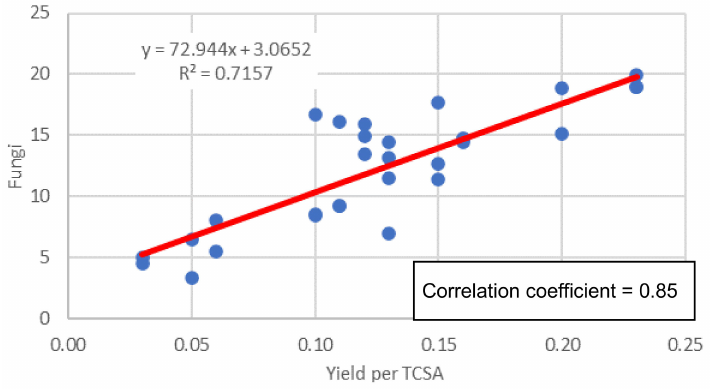
Figure 8. Correlation between yield per tree cross-sectional area and fungi in 2008–2010.